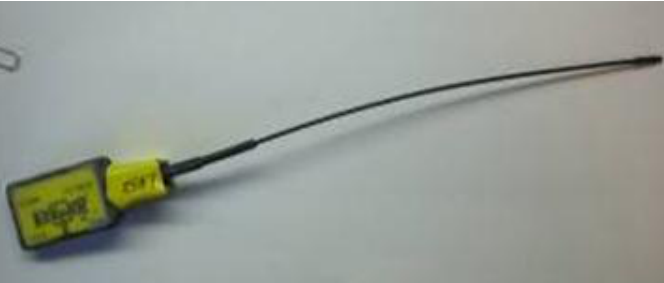
Figure 5. Very High Frequency (VHF) signal transmitter collar used in the positioning